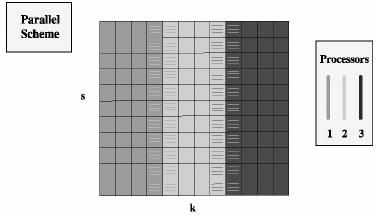
Figure 1. Representation of the inte- gration scheme for the regular mesh on ( t,y ) plane. Full curved arrows: upwind step of (2.7). Dot-dashed vertical ar- rows: quadrature of (2.8).